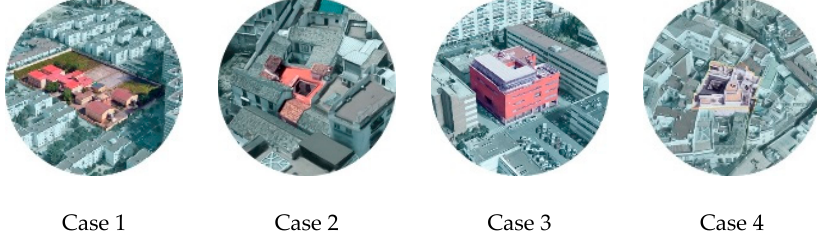
Figure 2. Cases study selected monitored for two-week in the cities of Seville and Cordoba (Spain).